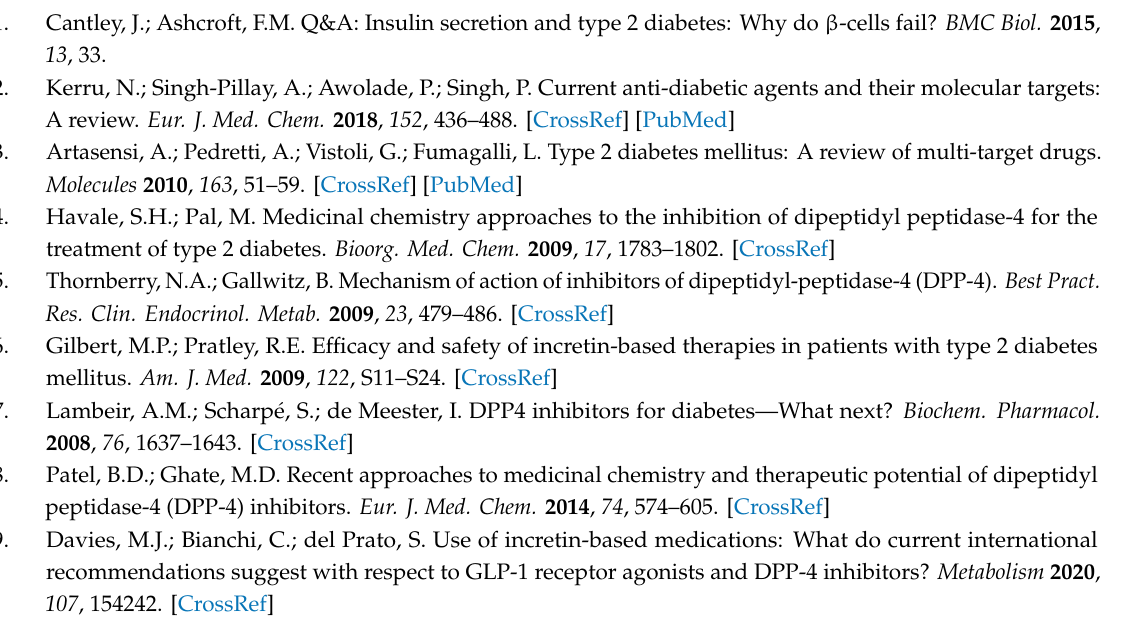
compound 2g , Figure S44: IR spectrum of compound 2h , Figure S45: 1 H NMR spectrum of compound 2h , Figure S46: 1 H NMR spectrum of compound 2h with integral values, Figure S47: 1 H NMR spectrum of compound 2h (2.3–12 ppm), Figure S48: 13 C NMR spectrum of compound 2h , Figure S49: HRMS spectrum of compound 2h , Figure S50: IR spectrum of compound 2i , Figure S51: 1 H NMR spectrum of compound 2i , Figure S52: 1 H NMR spectrum of compound 2i with integral values, Figure S53: 1 H NMR spectrum of compound 2i (3.8–12 ppm), Figure S54: 13 C NMR spectrum of compound 2i , Figure S55: HRMS spectrum of compound 2i , Figure S56: IR spectrum of compound 2j , Figure S57: 1 H NMR spectrum of compound 2j , Figure S58: 1 H NMR spectrum of compound 2j with integral values, Figure S59: 1 H NMR spectrum of compound 2j (3.2–12 ppm), Figure S60: 13 C NMR spectrum of compound 2j , Figure S61: HRMS spectrum of compound 2j , Figure S62: IR spectrum of compound 2k , Figure S63: 1 H NMR spectrum of compound 2k , Figure S64: 1 H NMR spectrum of compound 2k with integral values, Figure S65: 1 H NMR spectrum of compound 2k (2.5–12 ppm), Figure S66: 13 C NMR spectrum of compound 2k , Figure S67: HRMS spectrum of compound 2k , Figure S68: IR spectrum of compound 2l , Figure S69: 1 H NMR spectrum of compound 2l , Figure S70: 1 H NMR spectrum of compound 2l with integral values, Figure S71: 1 H NMR spectrum of compound 2l (2.5–3.5 ppm), Figure S72: 1 H NMR spectrum of compound 2l (6.5–12 ppm), Figure S73: 13 C NMR spectrum of compound 2l , Figure S74: HRMS spectrum of compound 2l , Figure S75: IR spectrum of compound 2m , Figure S76: 1 H NMR spectrum of compound 2m , Figure S77: 1 H NMR spectrum of compound 2m with integral values, Figure S78: 1 H NMR spectrum of compound 2m (1–3.3 ppm), Figure S79: 1 H NMR spectrum of compound 2m (6.5–12 ppm), Figure S80: 13 C NMR spectrum of compound 2m , Figure S81: HRMS spectrum of compound 2m , Figure S82: IR spectrum of compound 2n , Figure S83: 1 H NMR spectrum of compound 2n , Figure S84: 1 H NMR spectrum of compound 2n with integral values, Figure S85: 1 H NMR spectrum of compound 2n (1–3.3 ppm), Figure S86: 1 H NMR spectrum of compound 2n (6.5–12 ppm), Figure S87: 13 C NMR spectrum of compound 2n , Figure S88: HRMS spectrum of compound 2n , Figure S89: IR spectrum of compound 2o , Figure S90: 1 H NMR spectrum of compound 2o , Figure S91: 1 H NMR spectrum of compound 2o with integral values, Figure S92: 1 H NMR spectrum of compound 2o (6.5–12 ppm), Figure S93: 13 C NMR spectrum of compound 2o , Figure S94: HRMS spectrum of compound 2o